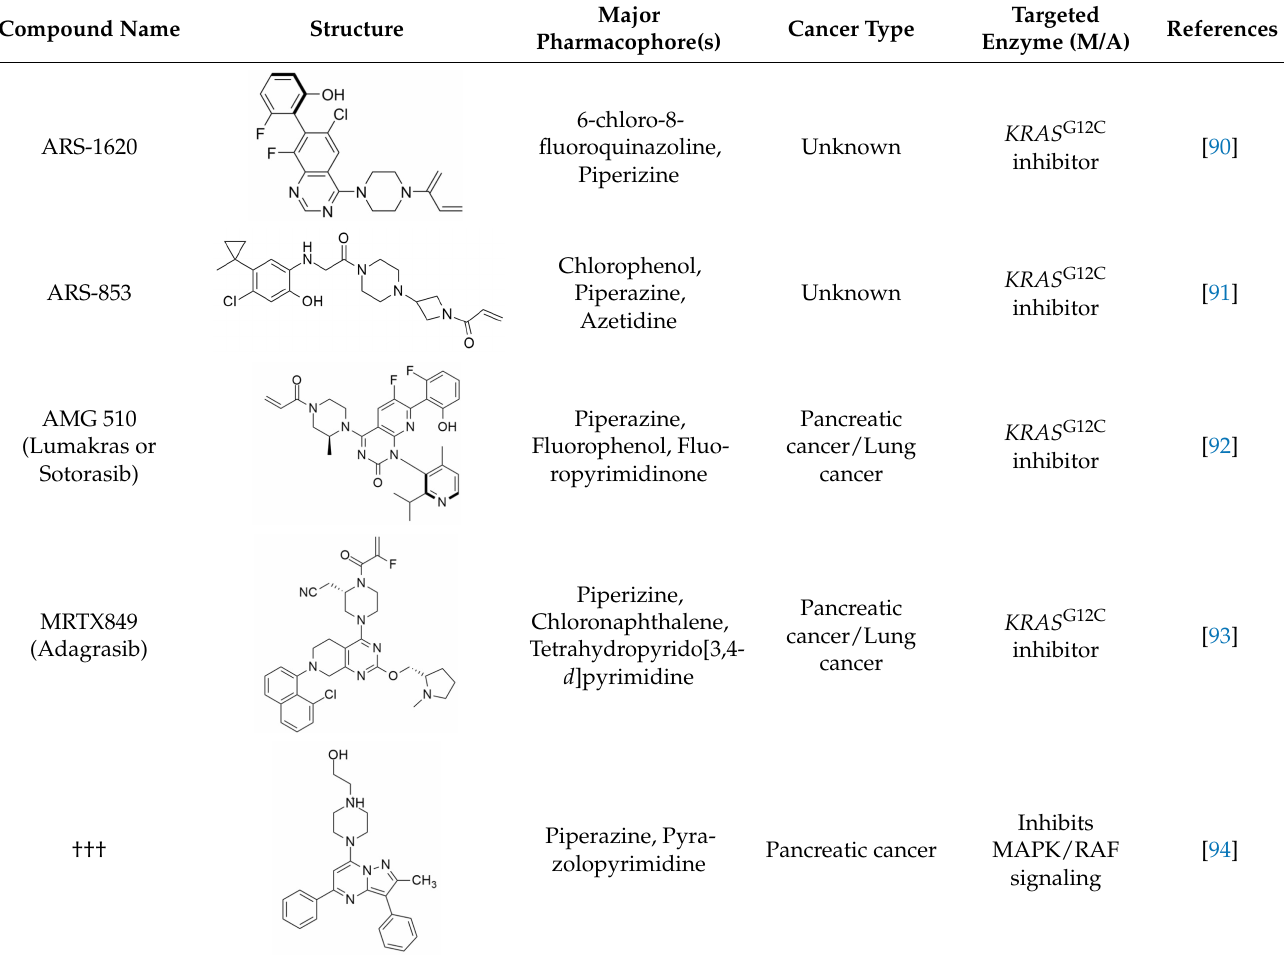
Table 2. Aza heterocyclic small-molecule RAS inhibitors with more than one nitrogen atom.